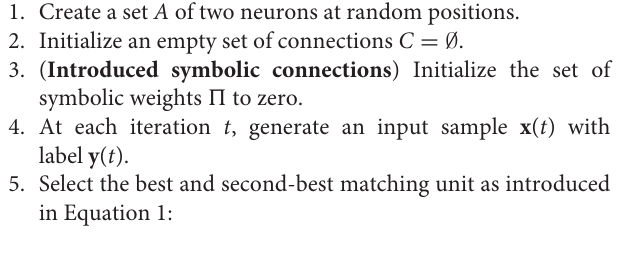
Algorithm 1: The GWR algorithm extended with the new neuron insertion